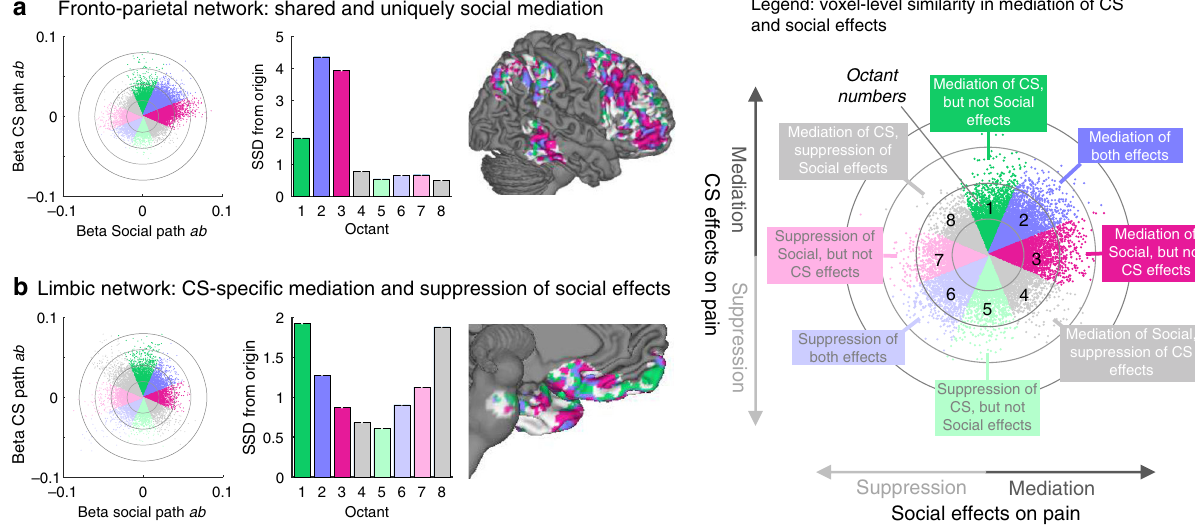
Fig. 5 Voxel-level spatial covariation in Social and CS mediation (path ab ) effects. Scatter plots display unthresholded single-voxel beta weights for CS ( y -axis) and Social ( x -axis) mediation effects (path ab ). Each dot represents a voxel. Different colors are assigned to eight octants that re fl ect positive mediation for CS but not Social effects (Octant 1), positive mediation effects for both (Octant 2), positive mediation of Social, but not CS effects (Octant 3), and so on. Radial grids display distance from the origin (0,0) in 0.02 unit steps. These maps are descriptive, unthresholded illustrations of mediation beta weights. Units are arbitrary. a Voxel-level similarity in the frontoparietal network, showing the highest sum of squared distances (SSD, displayed in bar plots) from the origin in Octants 2 and 3, re fl ecting shared (CS and Social) positive and uniquely positive mediation of Social effects, respectively. Voxels in Octants 1 – 3 (green, blue, and purple, respectively) within the frontoparietal network (light gray area) are displayed on a lateral brain surface plot (far right). b Voxel-level similarity in the limbic network, showing highest SSD in Octants 1 and 8 (see bar plot), re fl ecting selective mediation of CS effects and suppression of Social effects. Suppression effects are in the opposite direction from, and thus “ work against ” , the overall effects of cues on pain ratings. Voxels in Octants 1 – 3 (green, blue, and purple, respectively) in the limbic network (light gray area) are plotted on a medial brain surface (far right). See Supplementary Fig. 6 for the results in all seven large-scale networks. Source data are provided as a Source Data fi